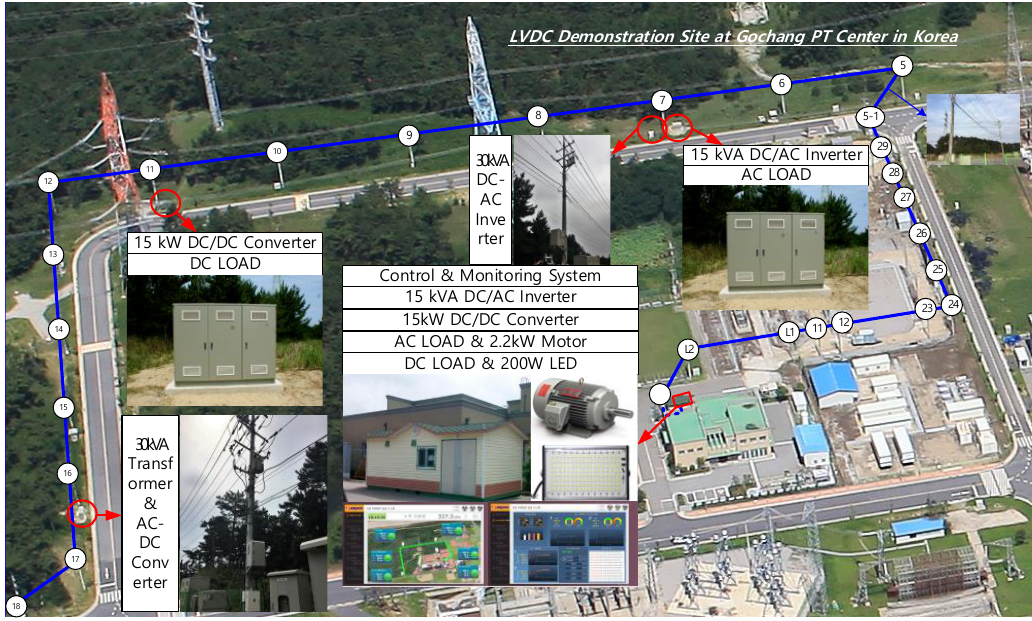
Figure 4. Korea Electric Power Corporation (KEPCO) demonstration site for low-voltage DC (LVDC) distribution.